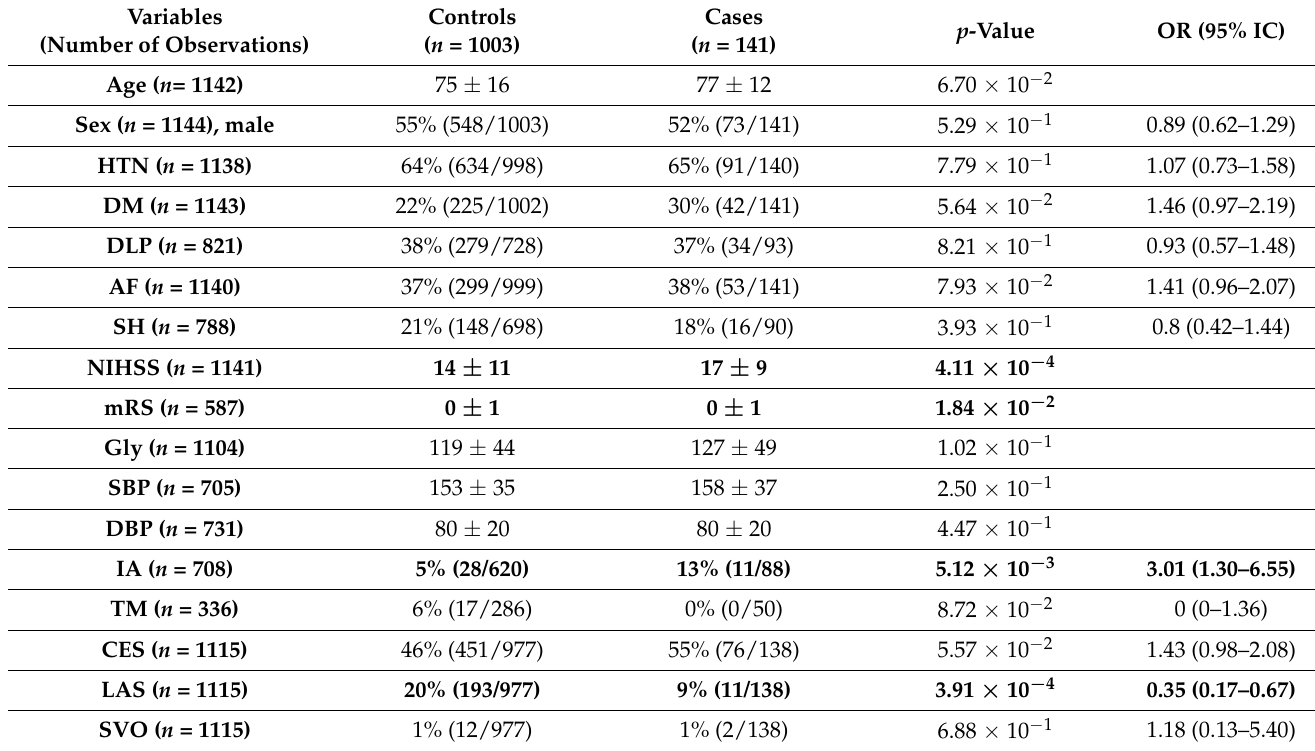
Table 3. Descriptive analysis of discovery cohort.